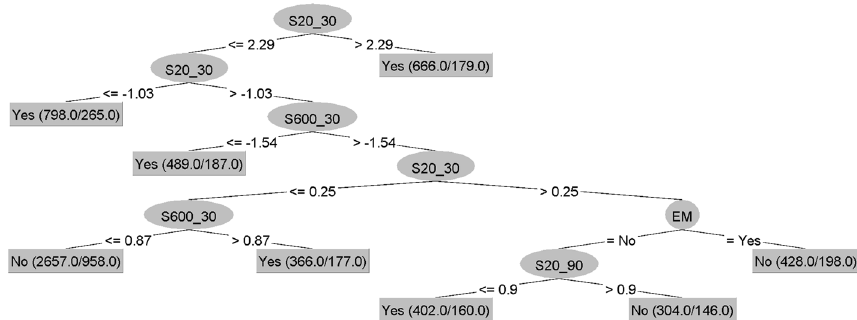
Fig. 3 Financial characteristics tree (Tree 1)